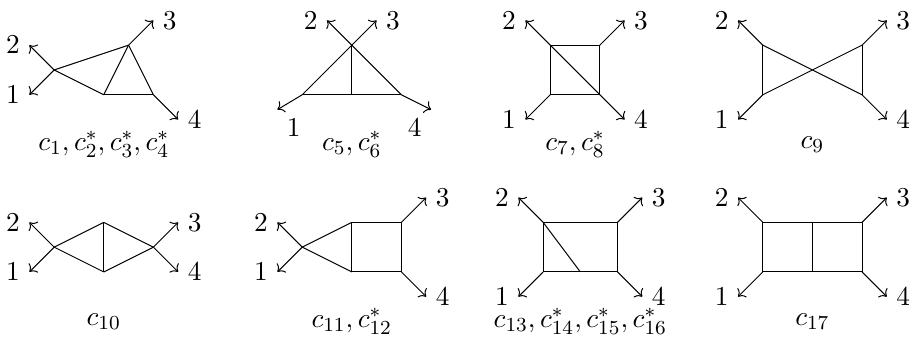
Figure 4 . Sectors corresponding to the cuts used in the d log analysis of the planar double box family. Sectors corresponding to the three cuts in equation (4.4) are c 7 ; c 13 ; c 17 . Labels with an asterisk represent sectors that can be obtained by (cid:13)ip symmetries and are not explicitly